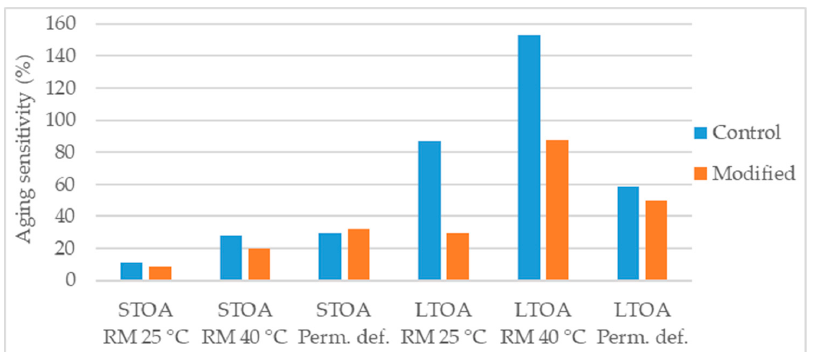
Figure 15. Aging sensitivity of the parameters considered in the study [58].